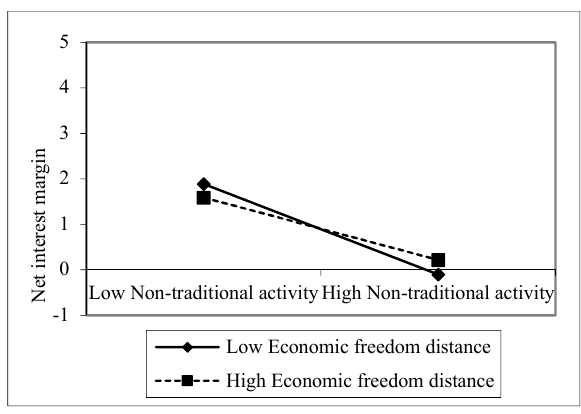
Figure 11. Non-Traditional Activity × Economic Freedom Distance.